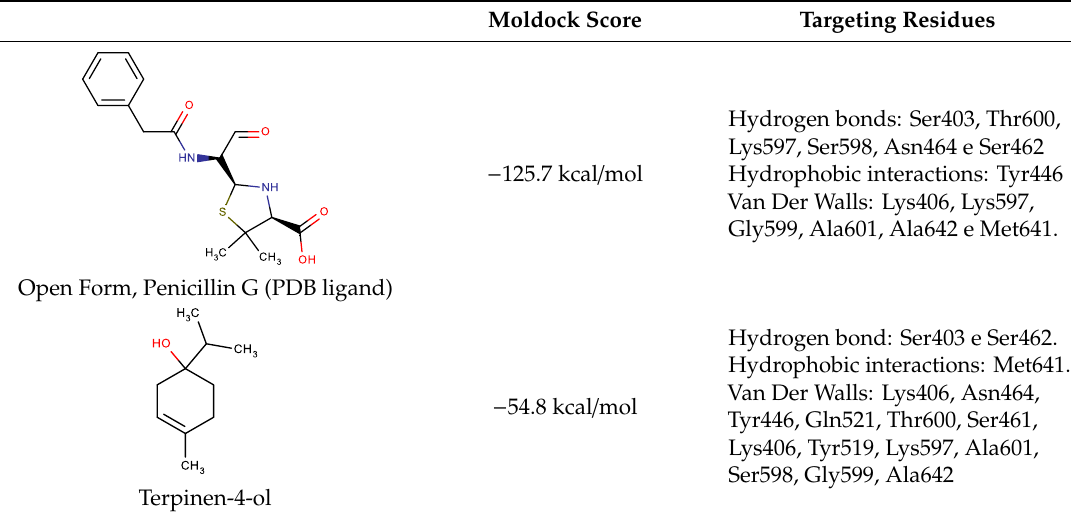
Table 2. Free binding energies and targeting residues of the PDB ligand and terpinen-4-ol in the interaction with PBP2a.